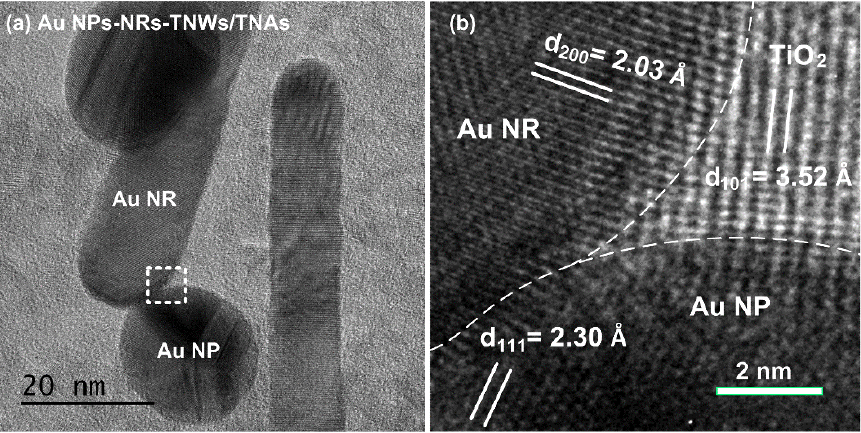
Figure 5. ( a ) An HRTEM image of Au-NPs-NRs-TNWs/TNAs (S 4 ). ( b ) An HRTEM image obtained from the dashed square area in panel ( a ), showing the crystal structure at the interface of Au NP–Au NR and TiO 2 .